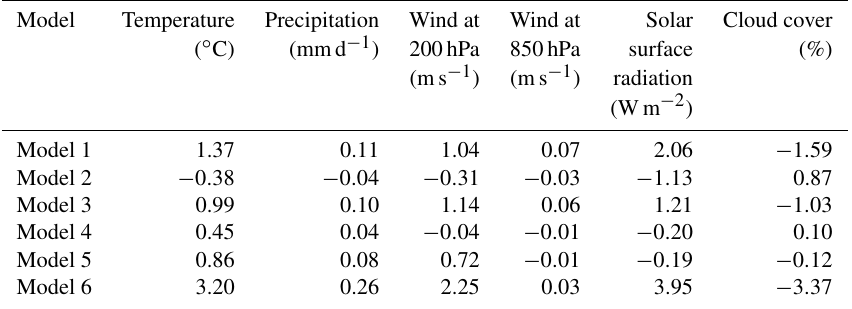
Table 2. Global mean average difference between the imperfect models and the perfect model, calculated over the last 30 years of the